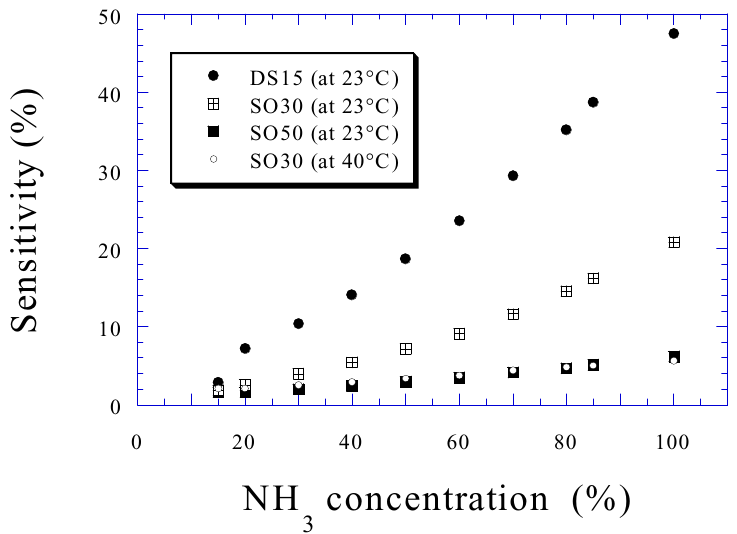
Figure 17. Ammonia sensitivity as a function of pore size and temperature.